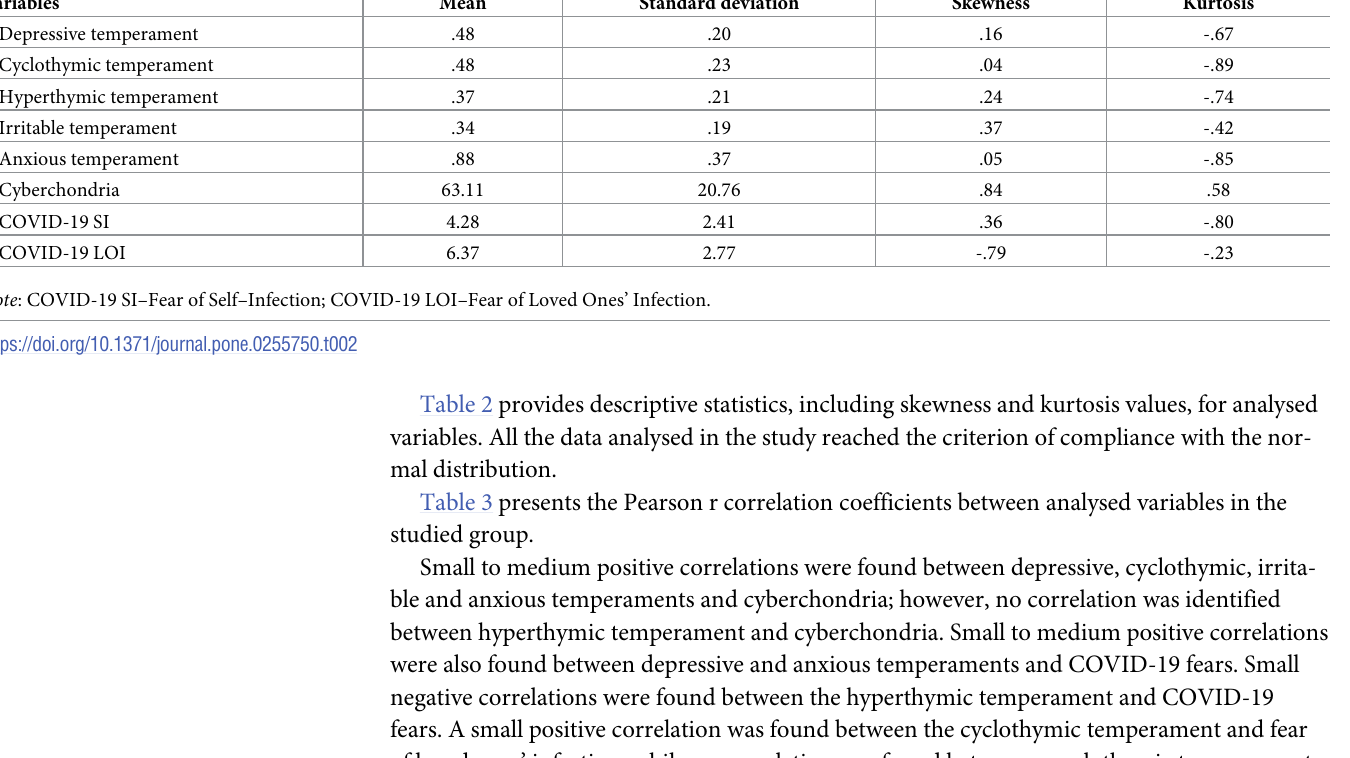
Table 2. Descriptive statistics, skewness and kurtosis values for analysed variables in the whole sample (N = 499). Variables